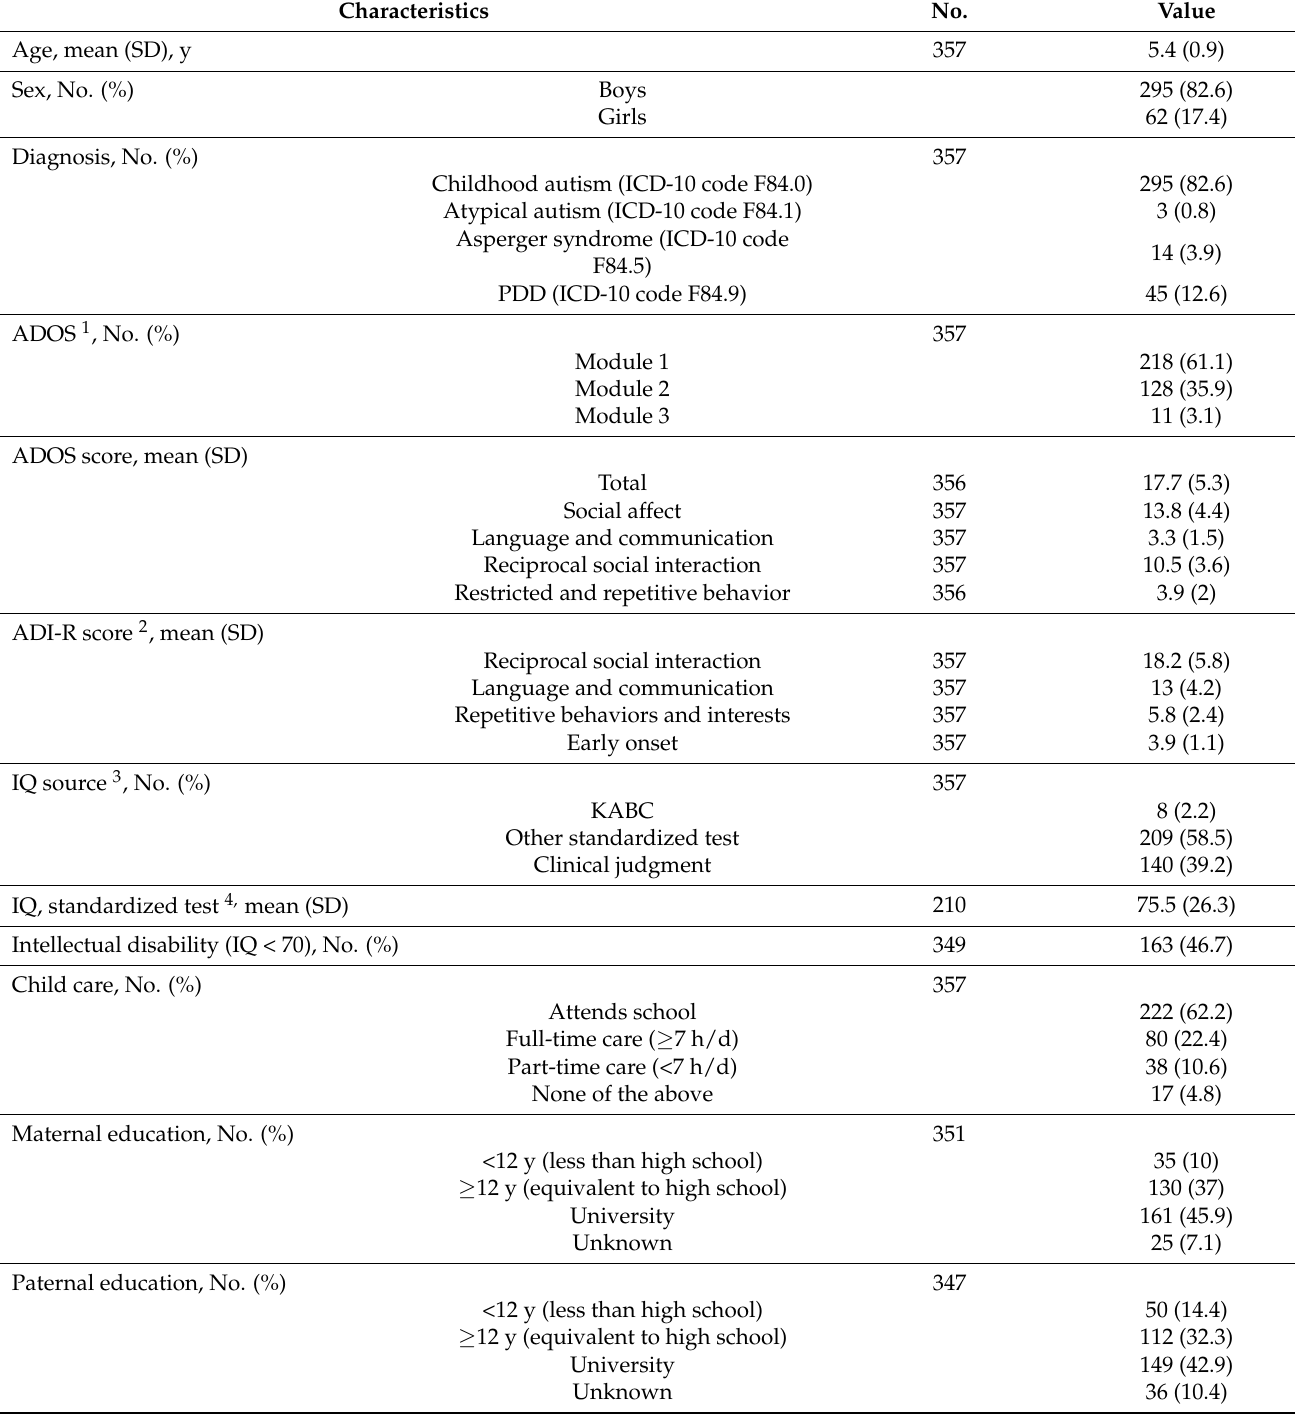
Table 1. Clinical and demographic characteristics of 357 children with autism spectrum